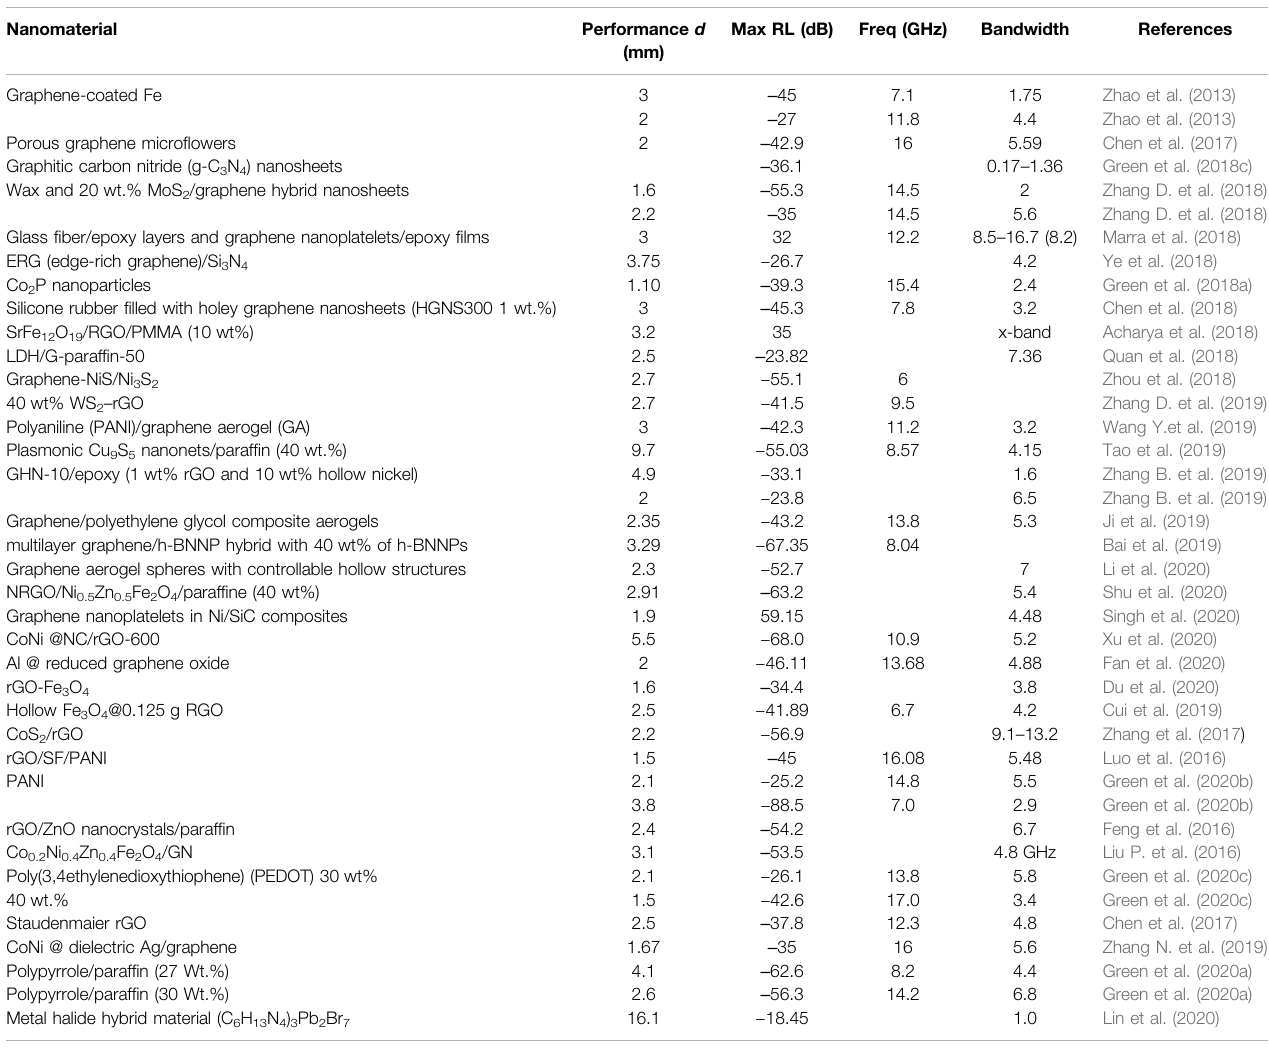
TABLE 2 | Graphene-based composites for microwave absorption.